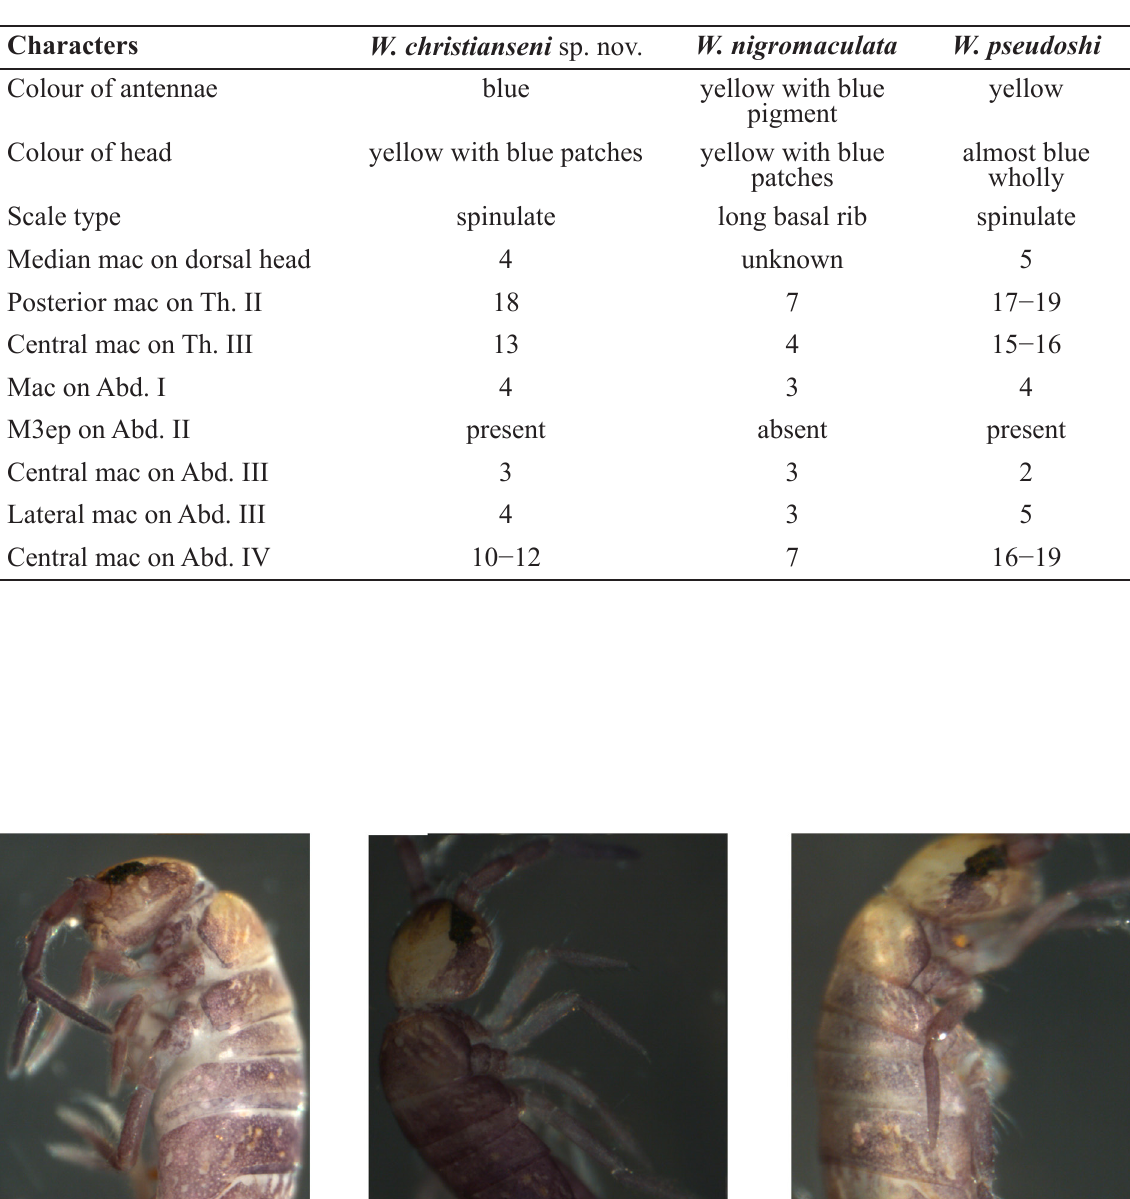
Table 3. Comparison of Willowsia christianseni sp. nov., W. nigromaculata (Lubbock, 1873) and W. pseudoshi Ma,